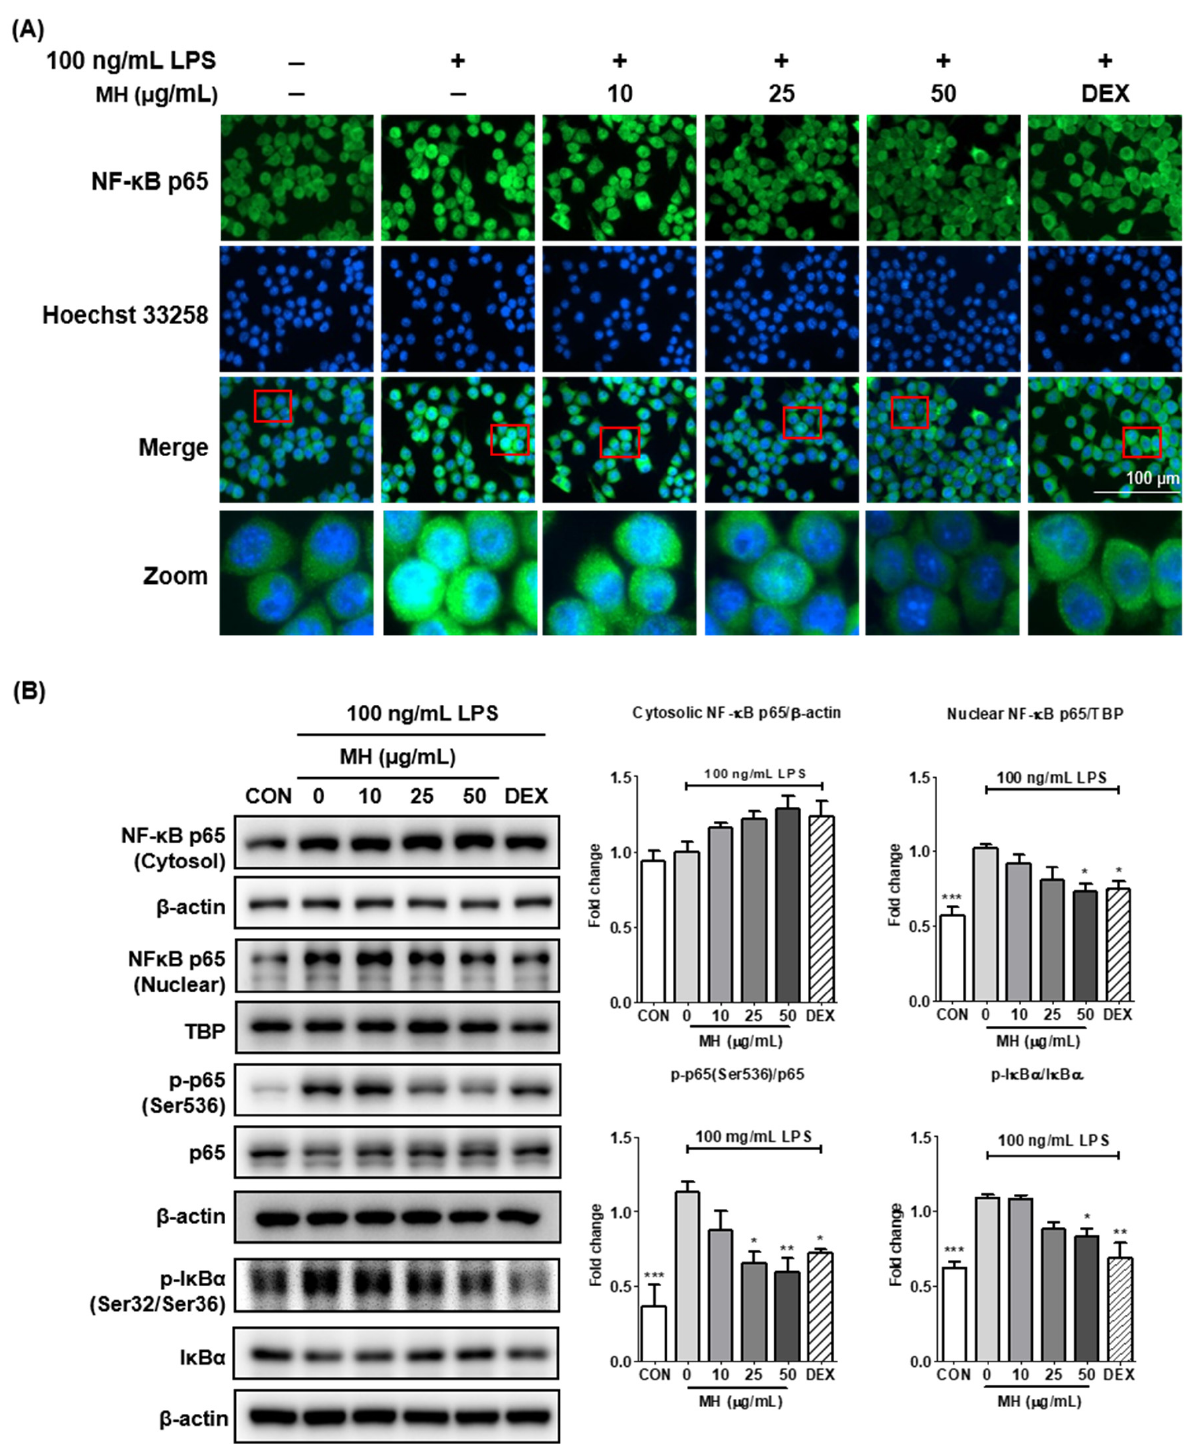
Figure 4. Effects of MH on the ( A ) translocation, ( B ) cytosol, nuclear protein expression, phosphory- lation of NF- κ B p65, and phosphorylation and degradation of I κ B α . The cells were preincubated with the indicated concentration of MH or 10 µ M DEX for 1 h before stimulation with LPS. The cells were stimulated with LPS for 1 h (NF- κ B p65) or 30 min (I κ B α ). Immunofluorescence staining was used for detecting NF- κ B p65 translocation. The cells were counterstained with Hoechst 33258. ( B ) β -actin was used as the cytosolic endogenous control. TBP was used as the nuclear endogenous control. Data are expressed as the mean ± SEM. * p < 0.05, ** p < 0.01, and *** p < 0.001 vs. LPS